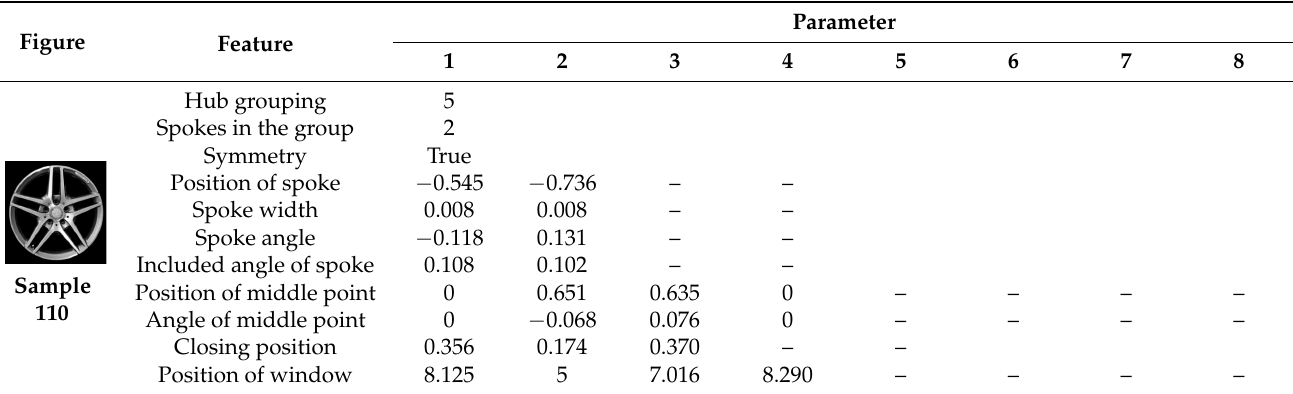
Table 3. Table of wheel hub feature parameters.